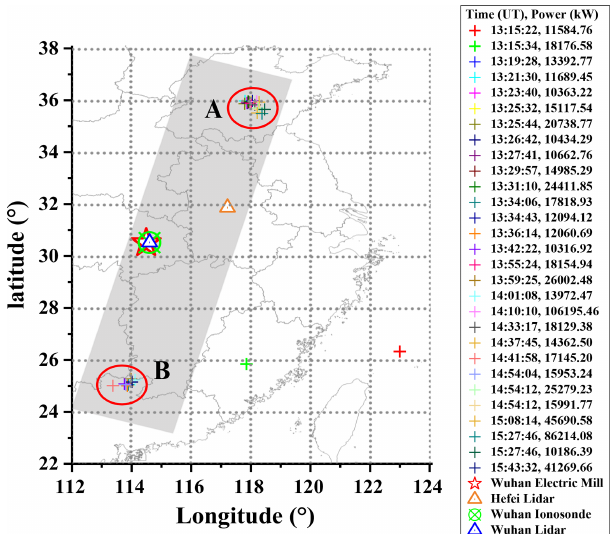
Figure 4. The lightning strokes are detected by WWLLN. The continuously strongest lightnings with a power larger than 10 4 kW occur from 13:19 to 15:43UT, mainly concentrated around areas within 35.8 ◦ N, 118.1 ◦ E and 25.1 ◦ N, 113.8 ◦